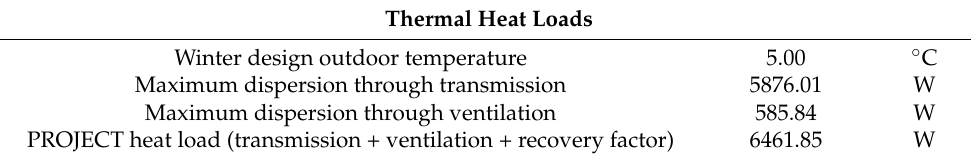
Table 7. Thermal heat